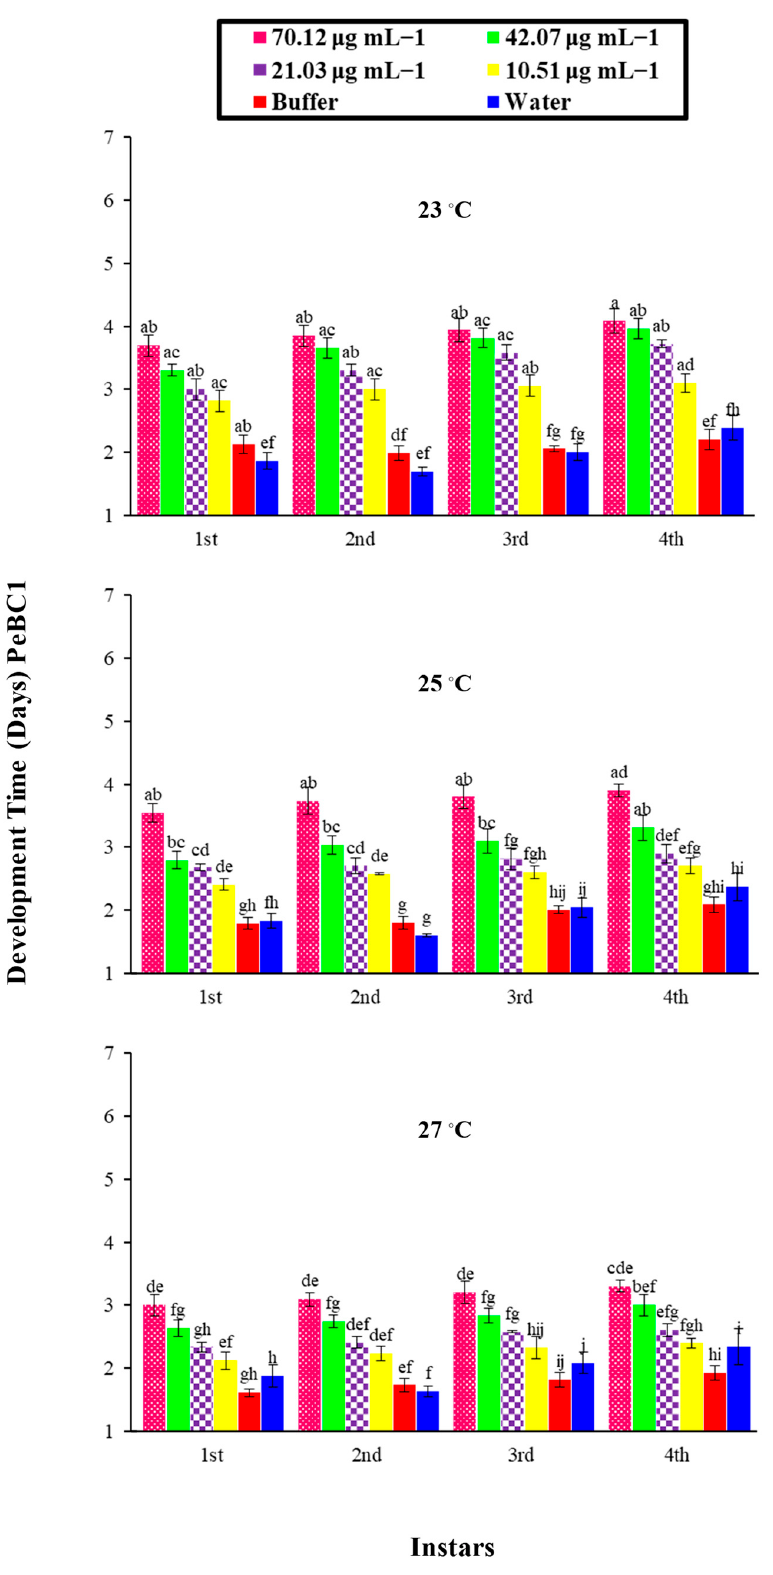
Figure 4. Mean developmental time (±SE) of different nymphal instars of M. persicae on chili plants by PeBC1 elicitor protein at different concentrations and different temperature (23, 25, 27 °C) regimes ( n = 10). Different alphabets above bar tops specify significant differences between treatments (factorial analysis one way ANOVA; LSD at α = 0.05).